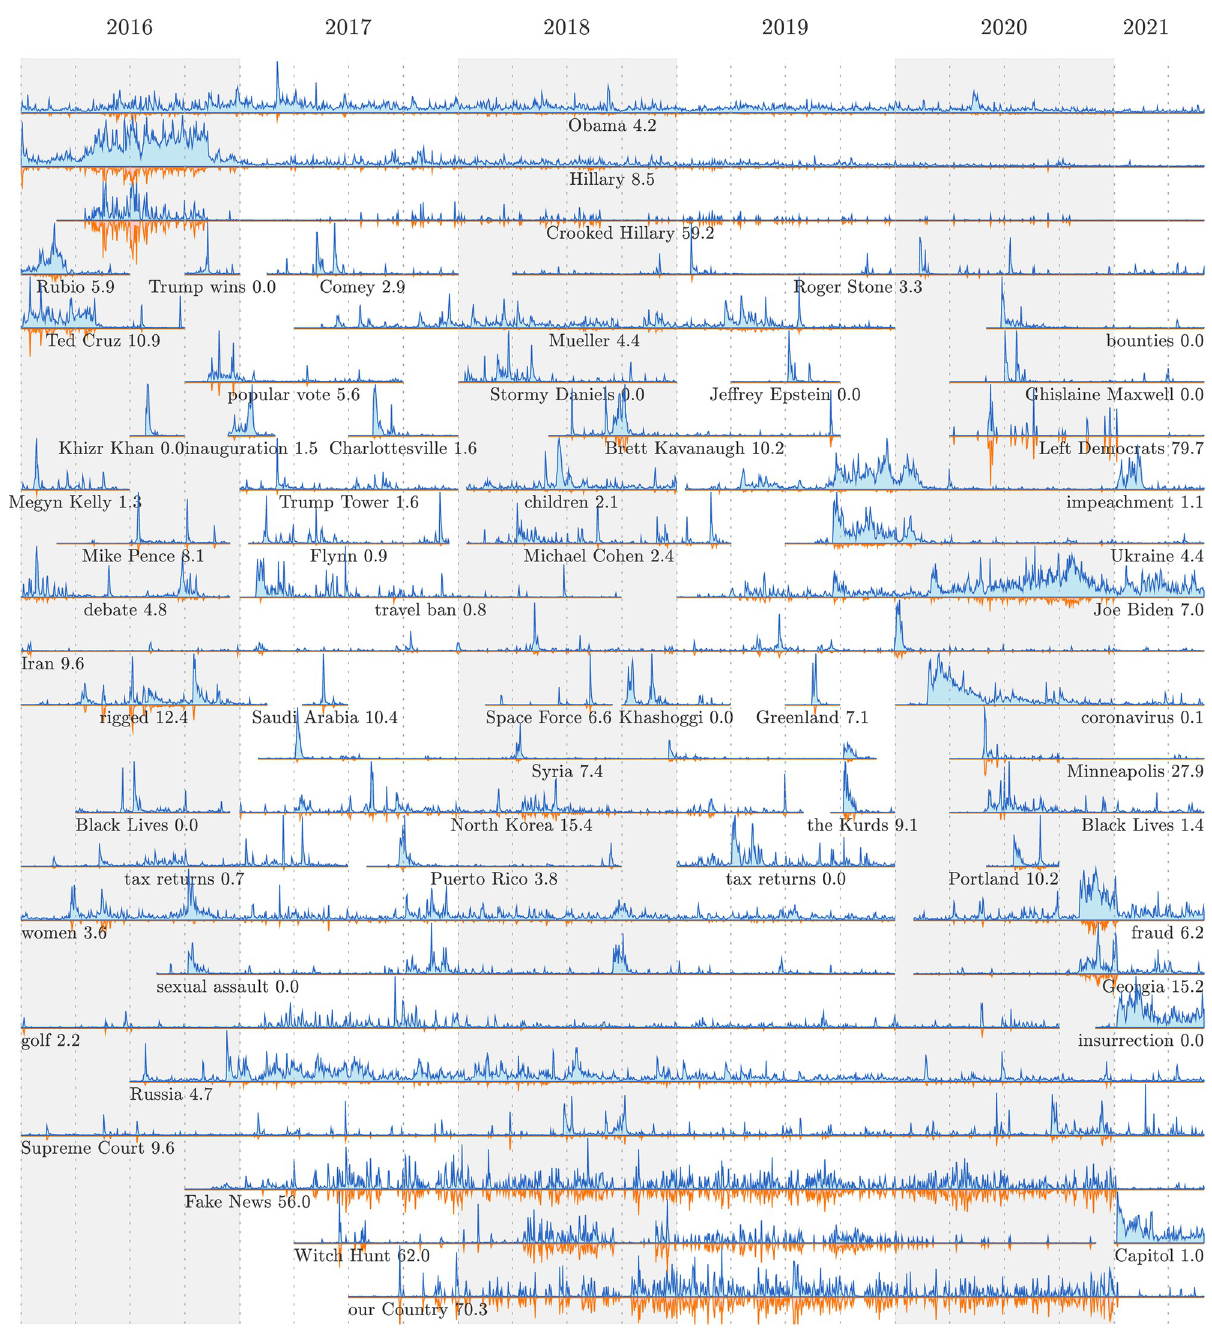
Fig 3. Example time series of narratively dominant 1-grams and 2-grams for Trump-matching tweets. Each time series shows the relative usage rate for n -grams (blue curve), and Trump’s level of narrative control (inverted orange curve with pale pink fill). See the Online Appendices (compstorylab. org/trumpstoryturbulence/) for full time series for all n -grams which have been narratively dominant on at least three days. The background shading and vertical dashed lines indicate years and quarters.